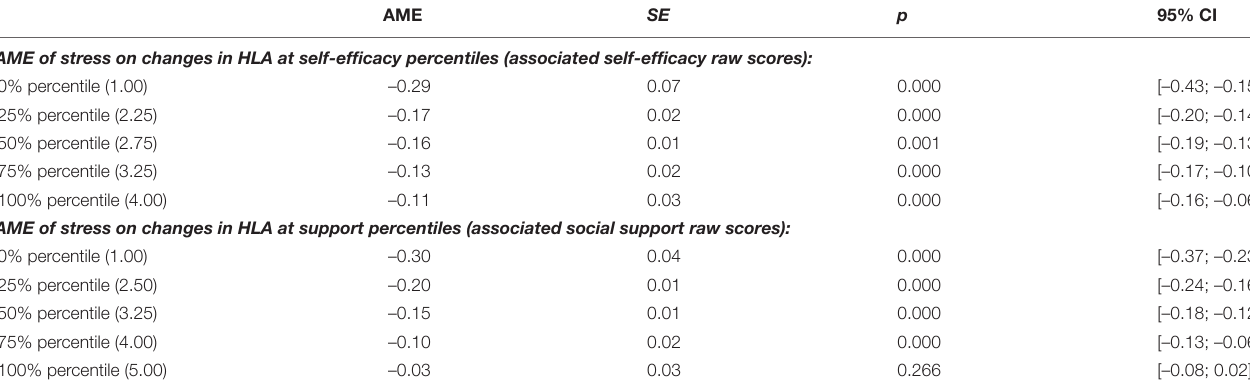
TABLE 5 | Average marginal effects of stress on changes in HLA at different percentiles of parental self-efficacy and perceived social support. AME SE p 95% CI AME of stress on changes in HLA at self-efficacy percentiles (associated self-efficacy raw scores): 0% percentile